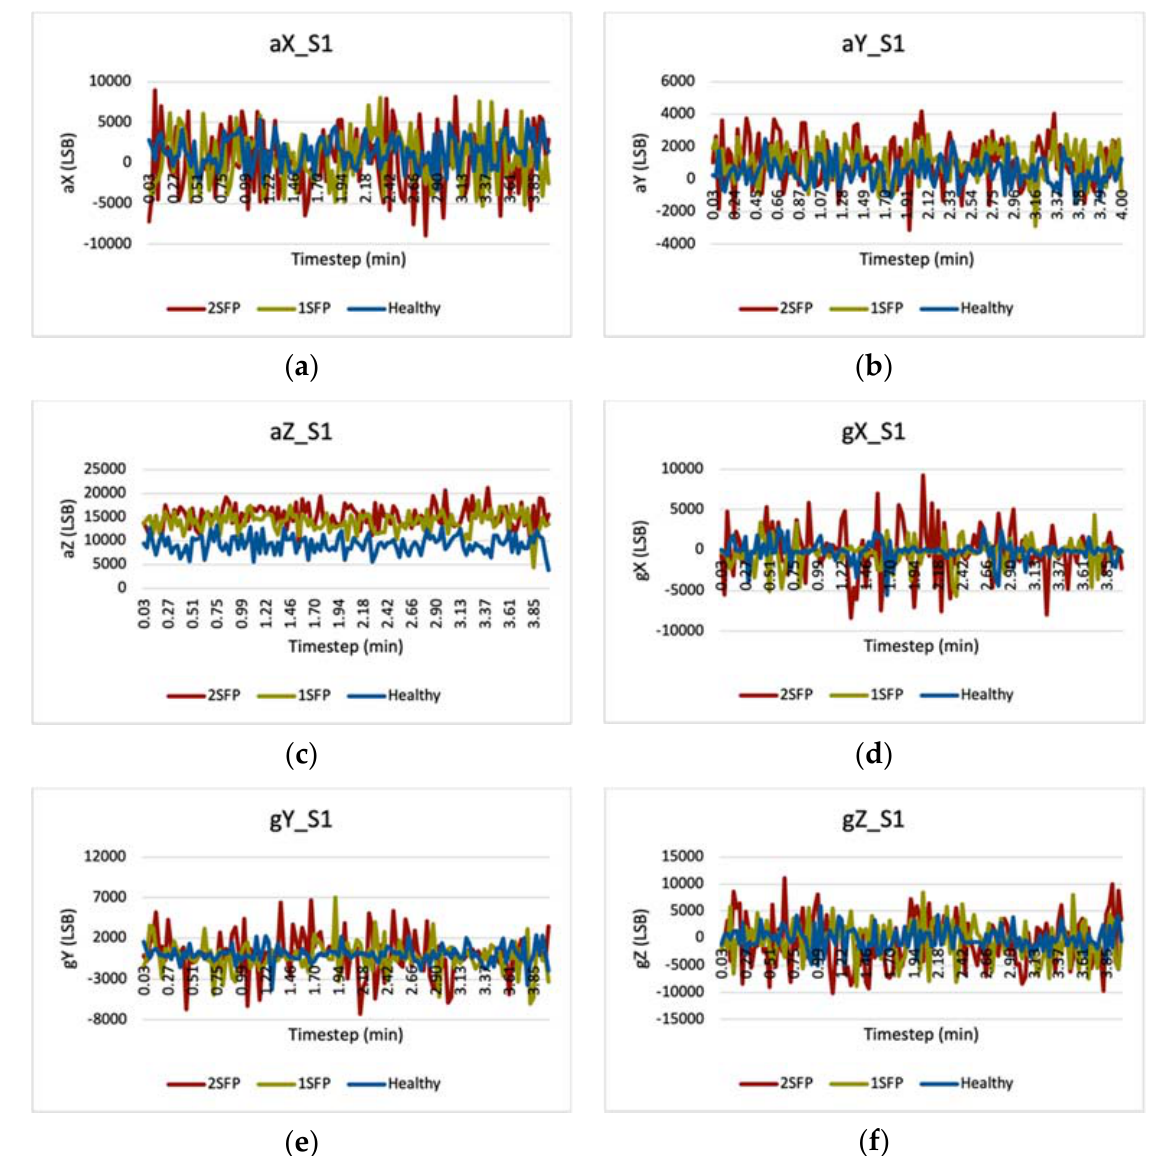
Figure 9. Measured Flight S1 Vibration Data for Parameter Sets ( a ) aX, ( b ) aY, ( c ) aZ, ( d ) gX, ( e ) gY, and ( f ) gZ.